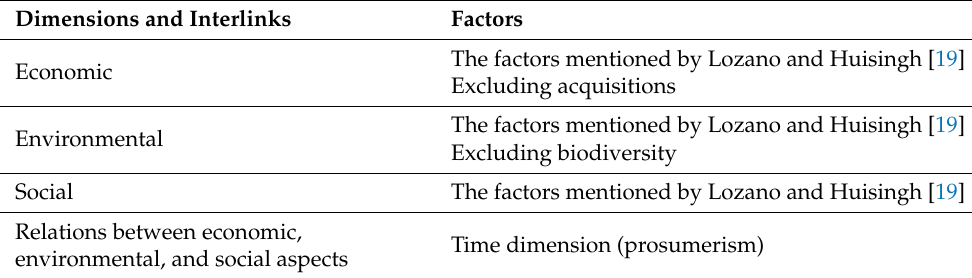
Table 1. A sustainability framework for